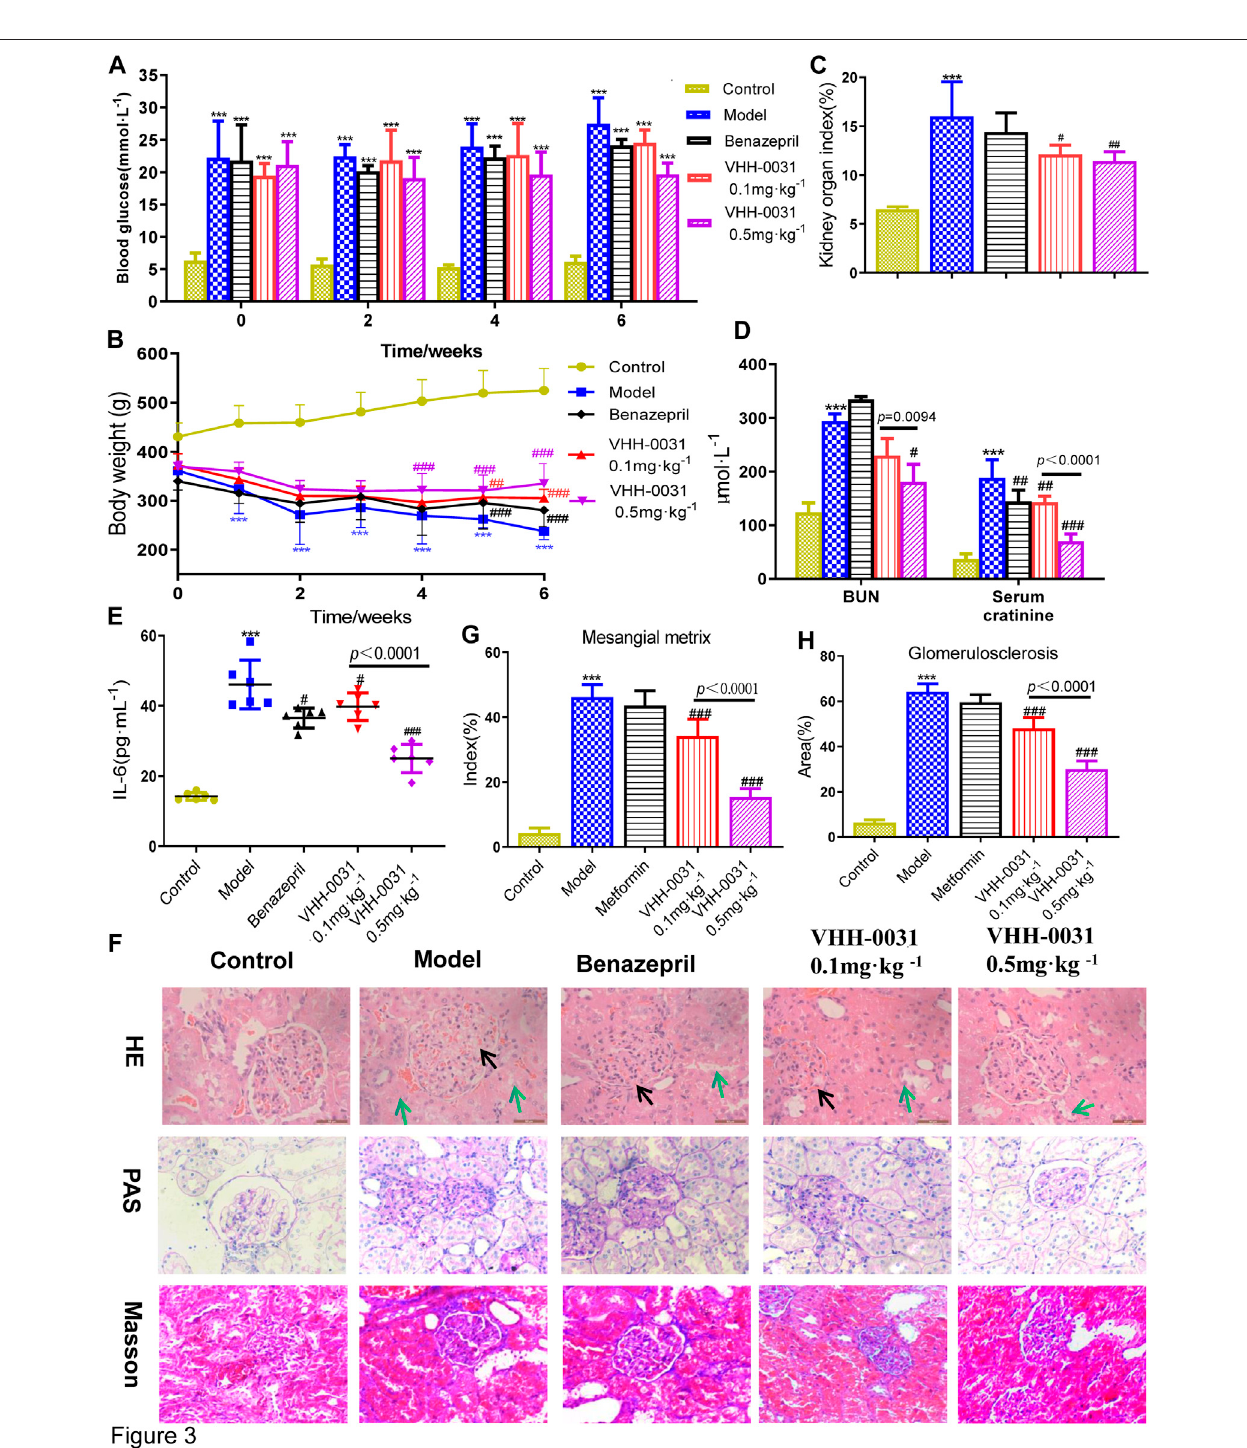
FIGURE 3 | The DN prevention in STZ-induced rats by VHH-0031. Rats were administrated with saline, benazepril (10 mg kg − 1 ), VHH-0031 (0.1 or 0.5 mg kg − 1 ) for 6 weeks, and then killed for study (A) Blood glucose level (B) Body weight change (C) The ratio of kidney weight to body weight (D) The level of blood urea nitrogenandserumcreatinineintheserumbyexperimental kit (E) ThelevelofIL-6intheserumbyELISA (F) Evaluationofmesangialexpansion,mesangialmetrixcaused by glycogen stimulation and glomerulosclerosis caused by collagen deposition in the kidney by H&E, PAS, Masson staining, Bar (cid:1) 100 μ m.The black arrow points toglomerularmesangialhyperplasia,thegreenarrowpointstorenaltubulecongestion andedema.Quanti fi cation analysisofmesangialmatrixindexbyPASstaining (G) and glomerulosclerosisbyMasson ’ strichrome staining (H) inkidneysBar (cid:1) 100 μ m. Datarepresentsthemean ± SDforsixratspergroup. Control: SDratswithoutSTZ treatment, Model: SD rats with STZ treatment, Benazepril 10 mg kg − 1 : SD rats with STZ treatment in presence of benazepril (10 mg kg − 1 ), VHH-0031 0.1 and 0.5 mg kg − 1 : SD rats with STZ treatment in presence of the recombinant anti-IL-6R fusion proteins (0.1 and 0.5 mg kg − 1 ). ** p < 0.01, *** p < 0.001 vs control group, # p < 0.05, ## p < 0.01, ### p < 0.001 vs model